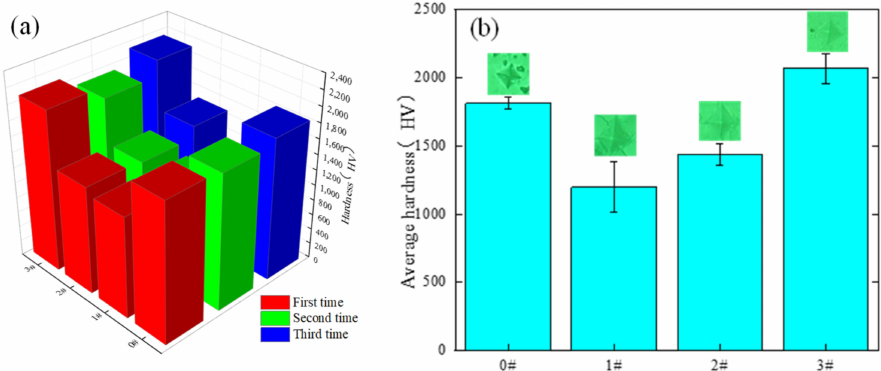
Figure 12. Laser polishing surface hardness surface change. ( a ) change in surface hardness of alumina, ( b ) change in average surface hardness.